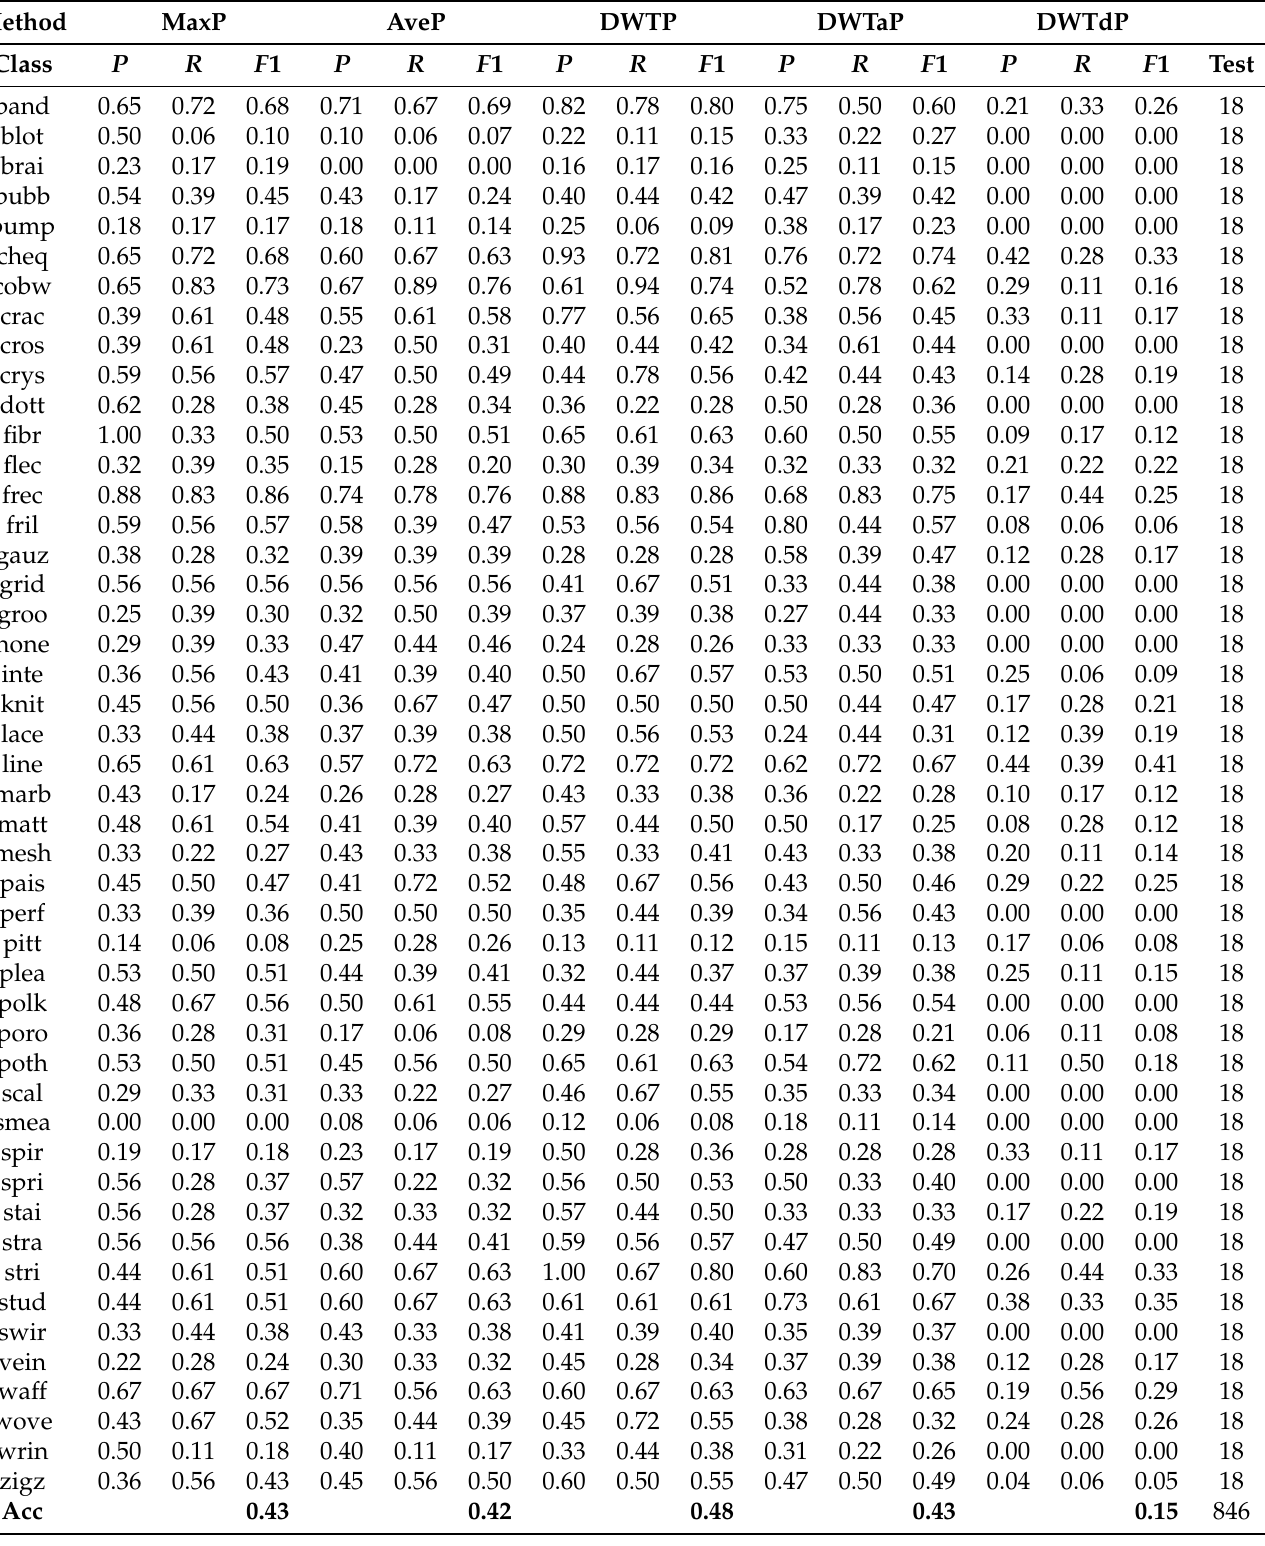
Table A3. Experiment 2 with Adam Optimizer—classification report for the DTD